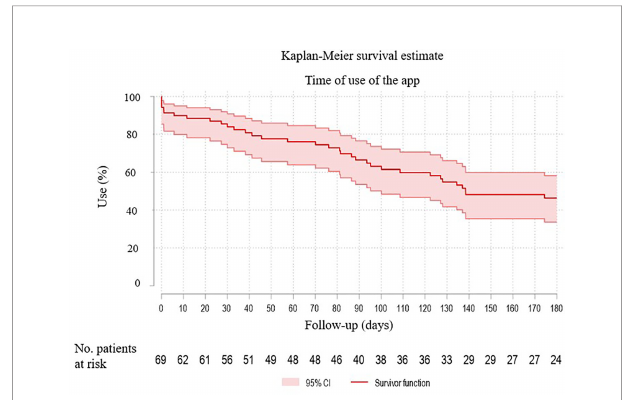
FIGURE 5 | Kaplan-Meier survival estimates the use of the app during the